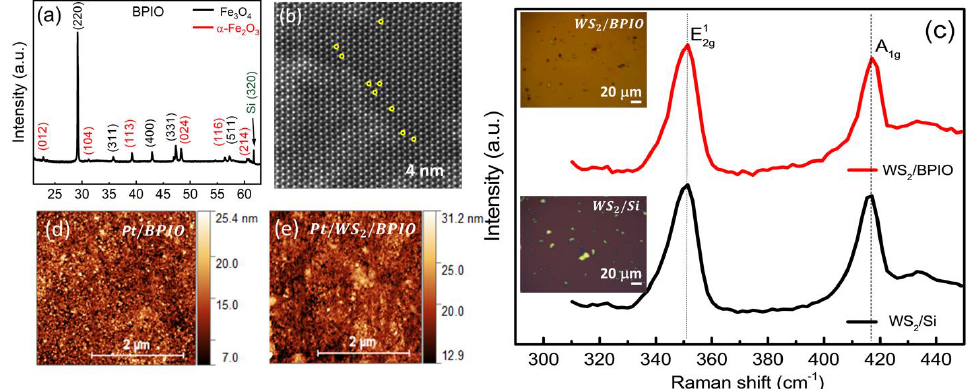
Figure 1. ( a ) X − ray diffraction (XRD) pattern for the 20 nm thick BPIO film. ( b ) WS 2 flakes under high resolution scanning transmission electron microscopy (STEM). The yellow circles indicate S vacancies in WS 2 . ( c ) Raman spectra for WS 2 flakes before (WS 2 /Si) and after (WS 2 /BPIO) the wet transfer process. Atomic force microscopy (AFM) was performed after Pt deposition for ( d ) Pt/BPIO and ( e ) Pt/WS 2 /BPIO. Insets of ( b ) indicate the optical images of WS 2 flakes on Si (before the transfer process) and BPIO (after the transfer process), respectively.